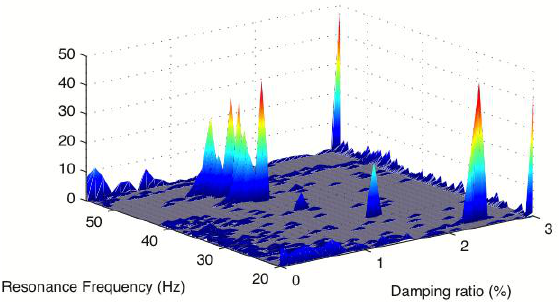
Fig. 11. Clusters of estimated poles from Tranmissibilities.